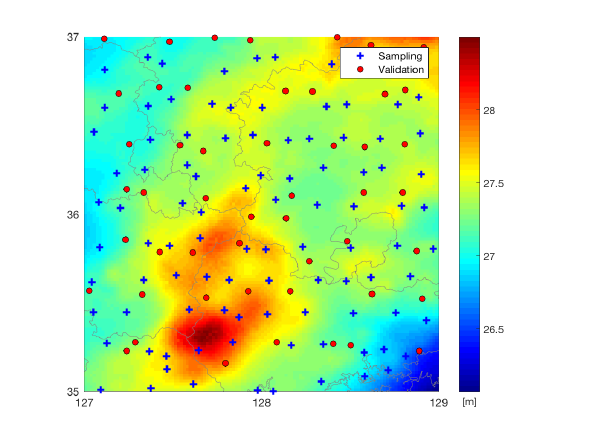
Figure 3: The geoid and the location of CORS for data sampling and validation. The geoid shows the residuals after removing the linear trend by fitting to a planar model (Bae, 2016).